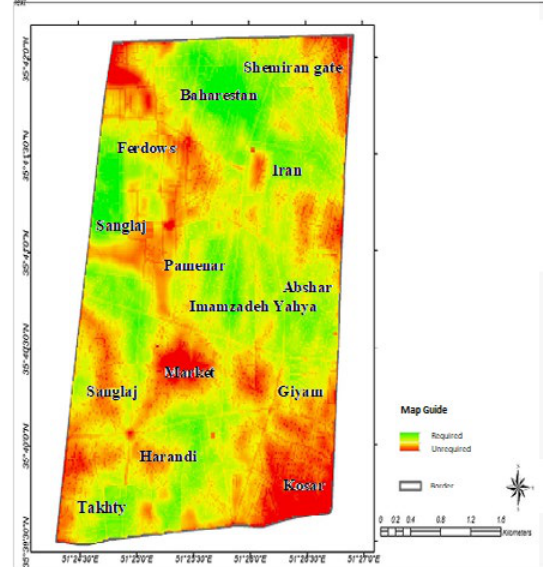
Fig. 22:- The final map of the suitable sites for construction of fire stations in the District 12